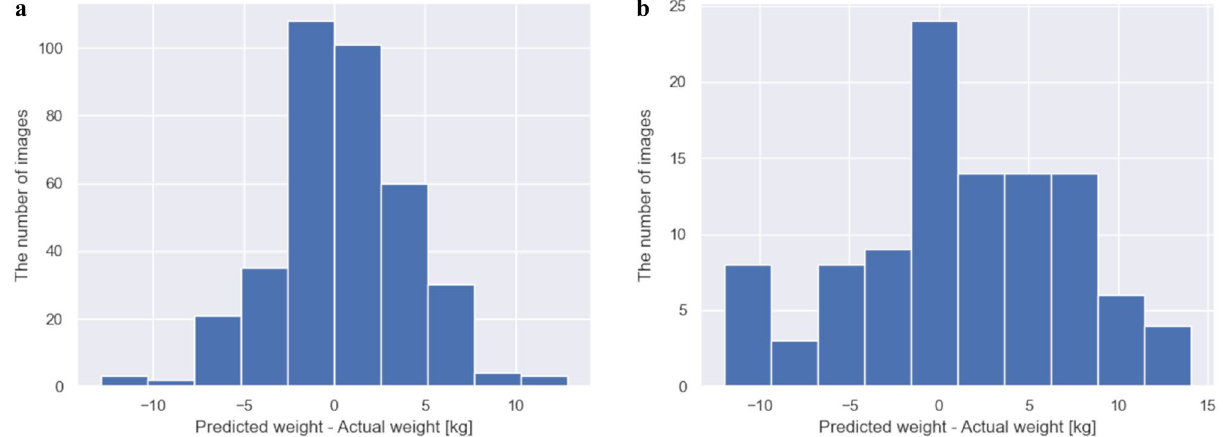
Figure 4. Histograms of the value of the differences between the actual and predicted body weights in ( a ) chest and ( b ) abdominal datasets.